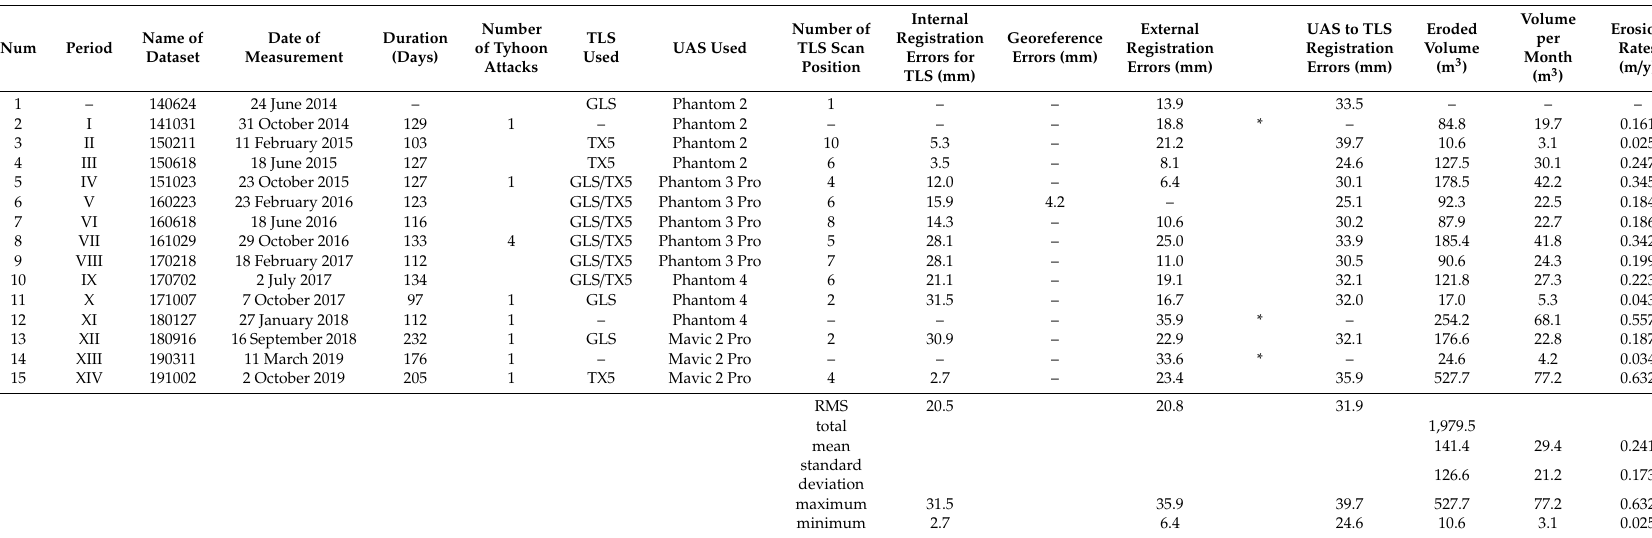
Table 1. Properties of the datasets for each field survey. Registration errors indicate the root mean square of the mean distances between the nearest points in the di ff erent point clouds. I–XIV indicate the periods between the pre- and post-change datasets that were for the calculations of the volume changes.